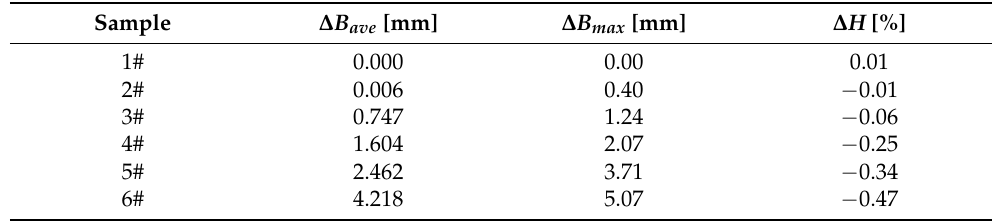
Figure 6. Shape deviations between bi-segment cylindrical preforms and the corresponding bulged hulls. Table 4. Bulging magnitudes and growth rate of height of six test bi-segment cylindrical